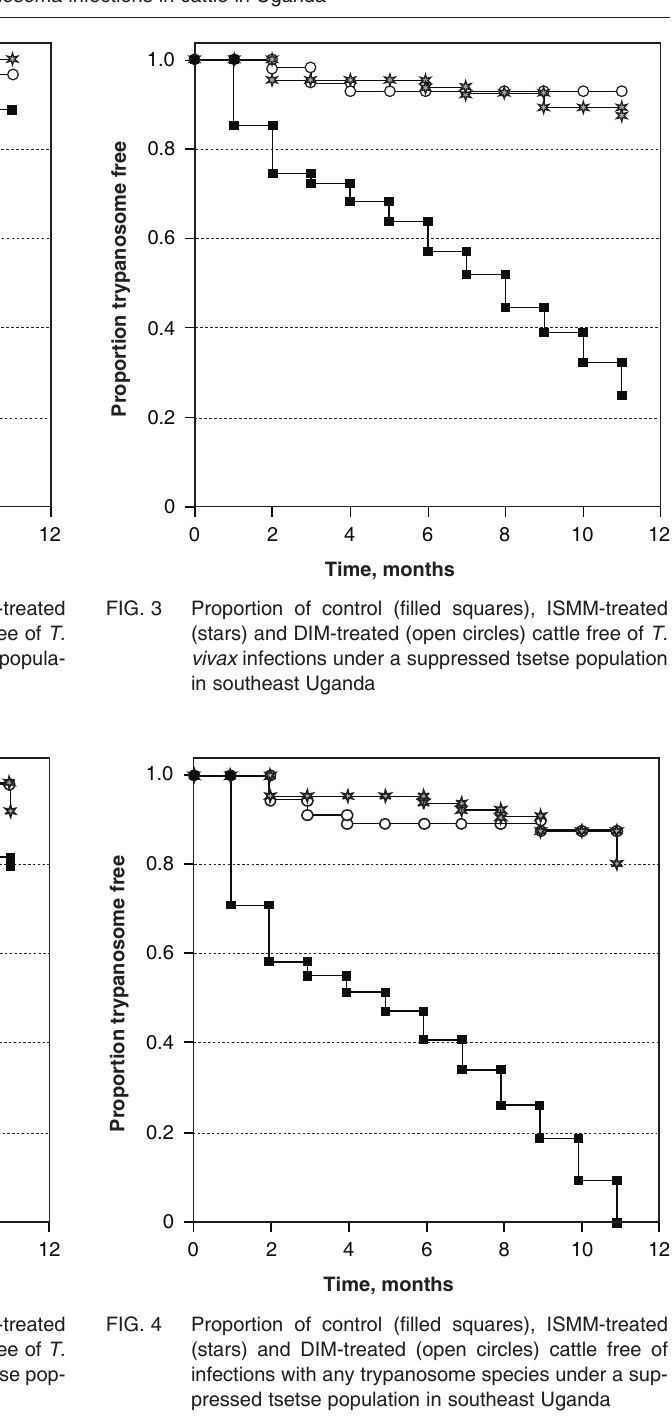
There was also no statistical difference in the mean time to infection with T. congolense in animals treated with ISMM or DIM (χ 2 = 2.36, d.f. = 1, P > 0.05), and the mean time to infection was signifi-